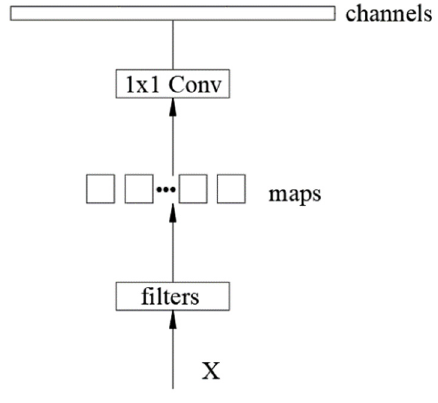
Figure 16. MobileNet model.